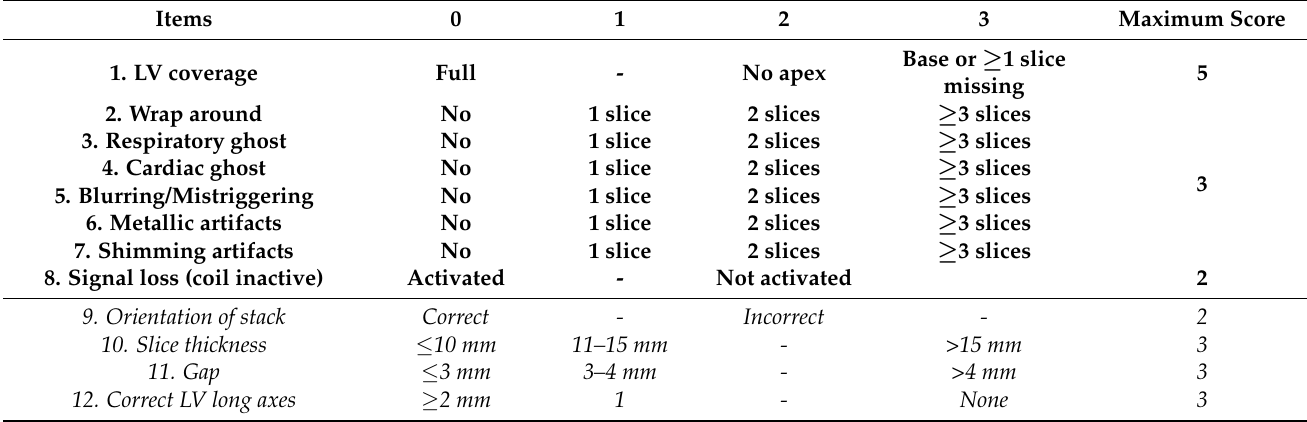
Table 2. “ LV-Function cine SSFP ” section of the standardized objective quality criteria score based on the European CMR registry. Adapted from [15] (p.